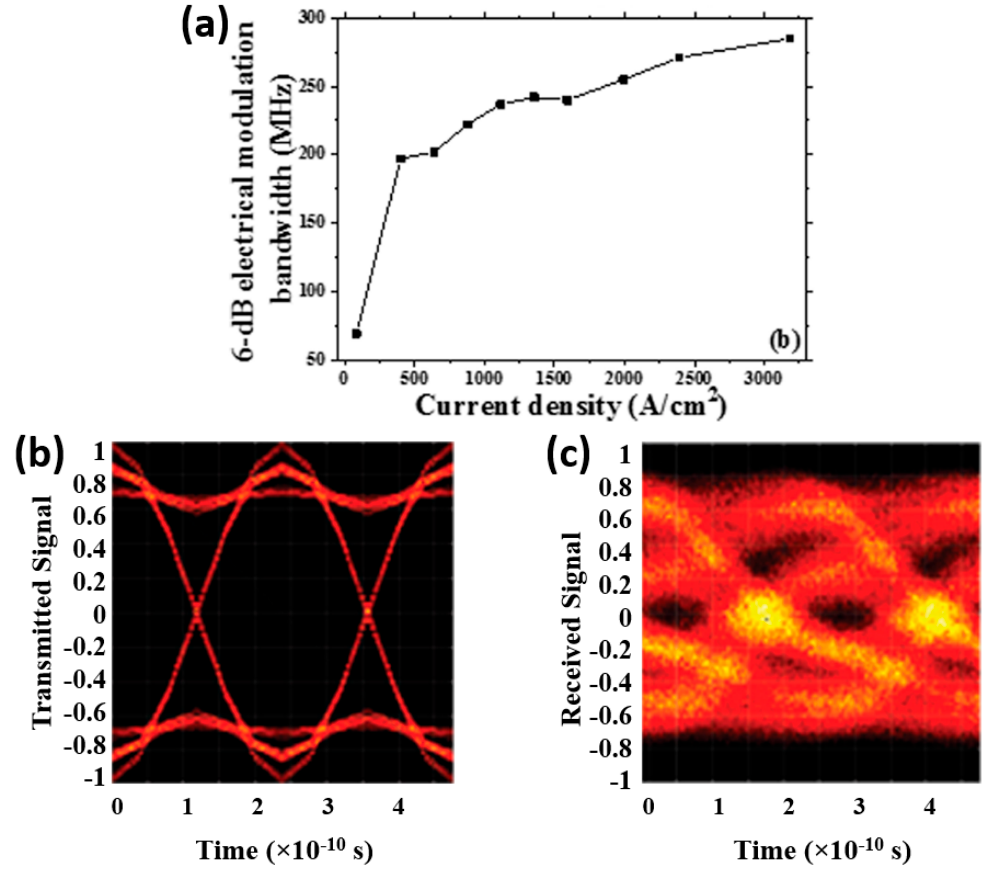
Figure 9. ( a ) 6-dB electrical bandwidth of the series-biased µ-LED array; eye diagrams of ( b ) transmitted and ( c ) received signals using on-off keying (OOK) at a bit rate of 700 Mbps without